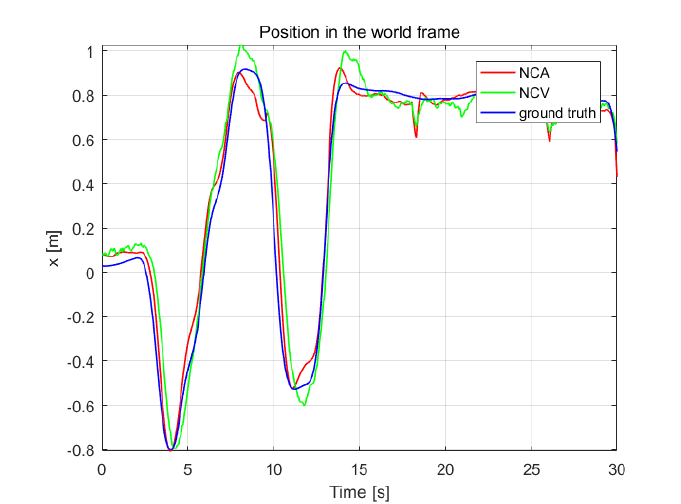
Figure 9. The position estimation in the world frame, compared with OptiTrack.